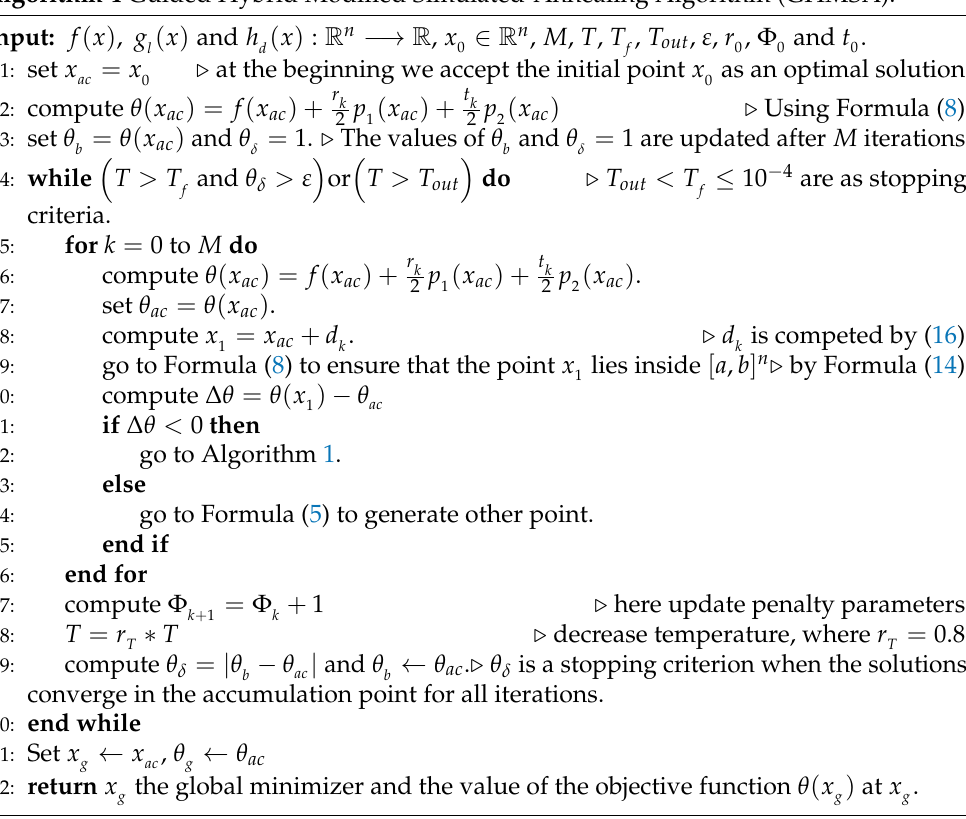
Algorithm 4 Guided Hybrid Modified Simulated-Annealing Algorithm